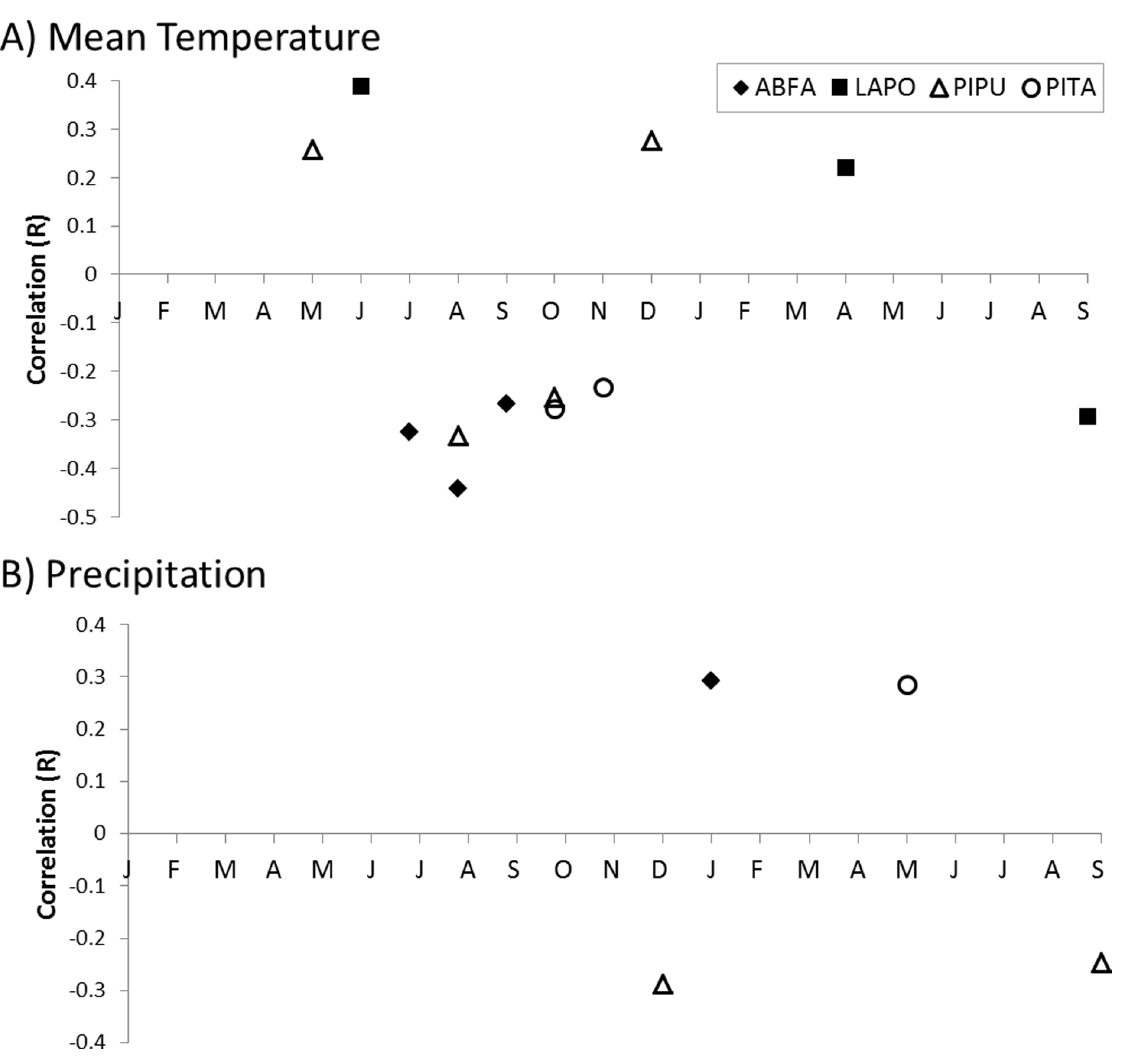
Figure 7. Correlation function analysis of tree growth to climate for trees of Jiuzhaigou National Nature Reserve. Results of growth and (A) mean temperature, and (B) precipitation for the 21-month period of time starting in January of the previous year through September of the current year’s growth from 1952 to 2007. See Fig. 2 for graphical summary of climate data used in this analysis [37]. Only significant values at p =0.05 are shown. Species codes as shown in the legend are ABFA ( Abies fargesii ), LAPO ( Larix potaninii ), PIPU ( Picea purpurea ) and PITA ( Pinus tabuliformis ).